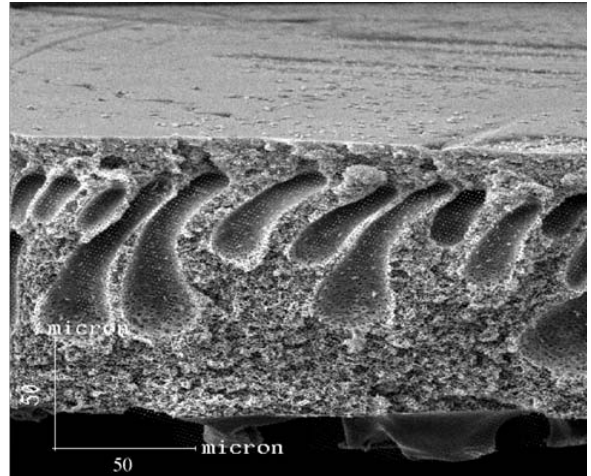
Figure 1. Scanning electron micrograph of cross-section of the asymmet- ric PSf